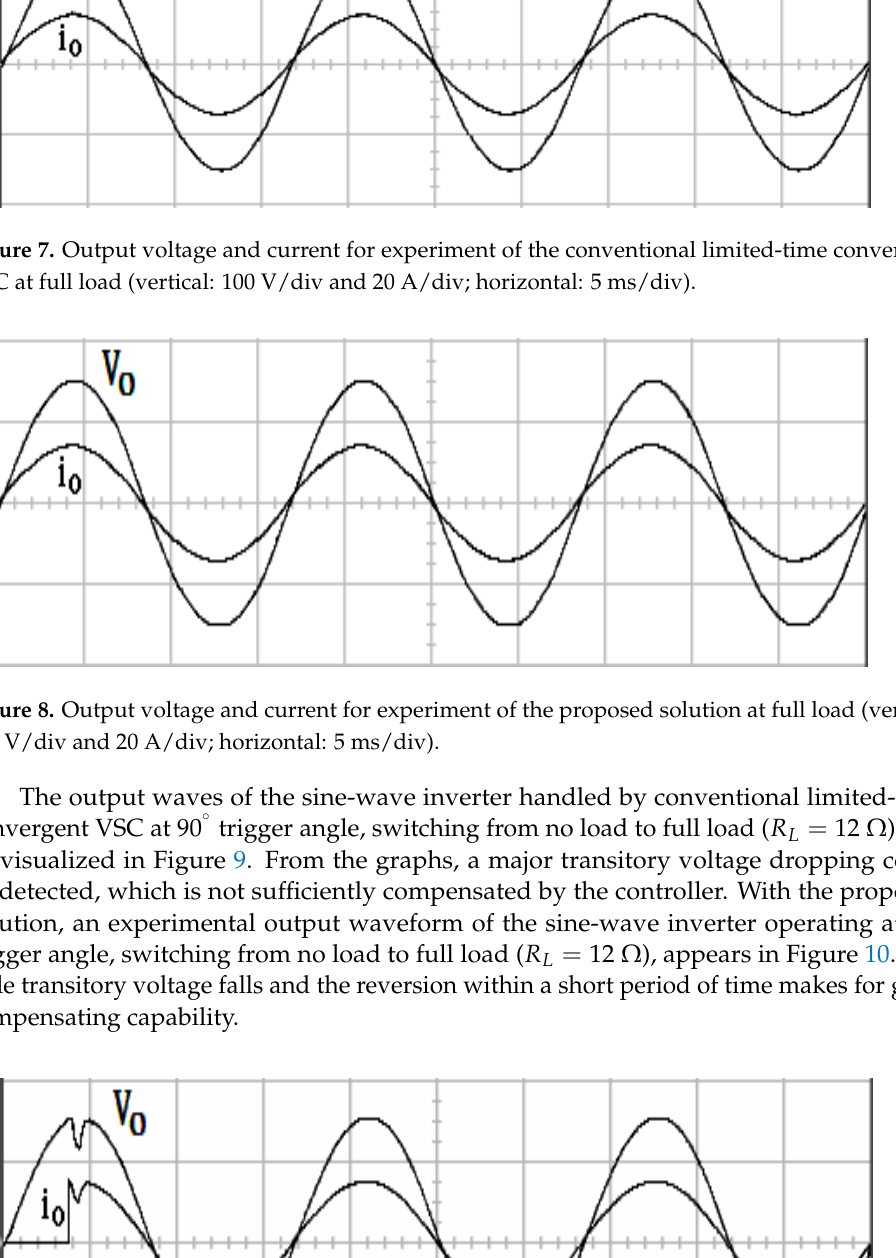
Figure 10. Output voltage and current for experiment of the proposed solution from no load to full load (vertical: 100 V/div and 20 A/div; horizontal: 5 ms/div). It is shown in Figure 11 that the measured waveform of the conventional lim ‐ ited ‐ time convergent VSC controlled inverter suffices for the similar loading case. One can examine the sinusoidal voltage waveform showing obvious warp distortion and high %THD of 12.11%, which is not ideal for steady ‐ state operation. The measured waveforms of the proposed solution with rectifier type load condition are provided in Figure 12. The output voltage waveform of the proposed converter approximates a si ‐